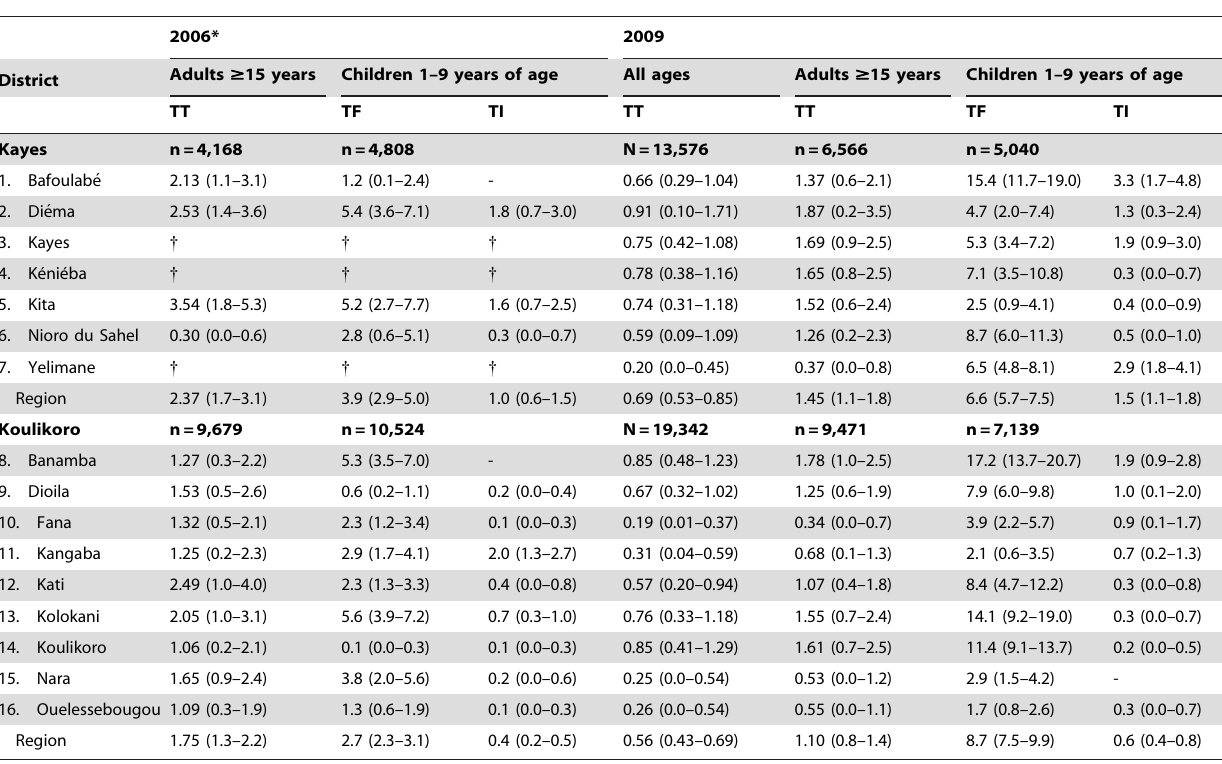
Table 3. Prevalence of clinical signs of trachoma in Kayes and Koulikoro Regions, Mali 2006 and